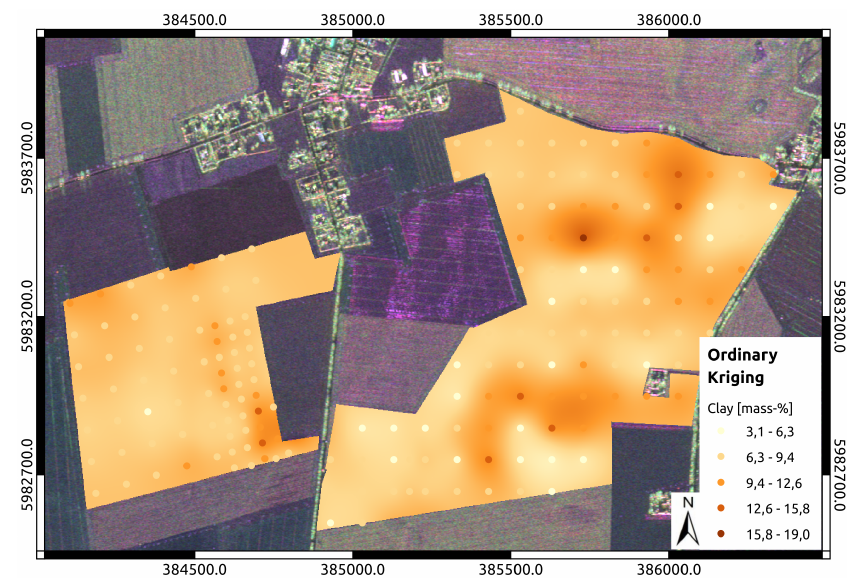
Figure 13. Spatial interpolated soil map for the texture class clay based on the OK approach. Circles display the sample locations and colors are scaled in the same color as background clay map.